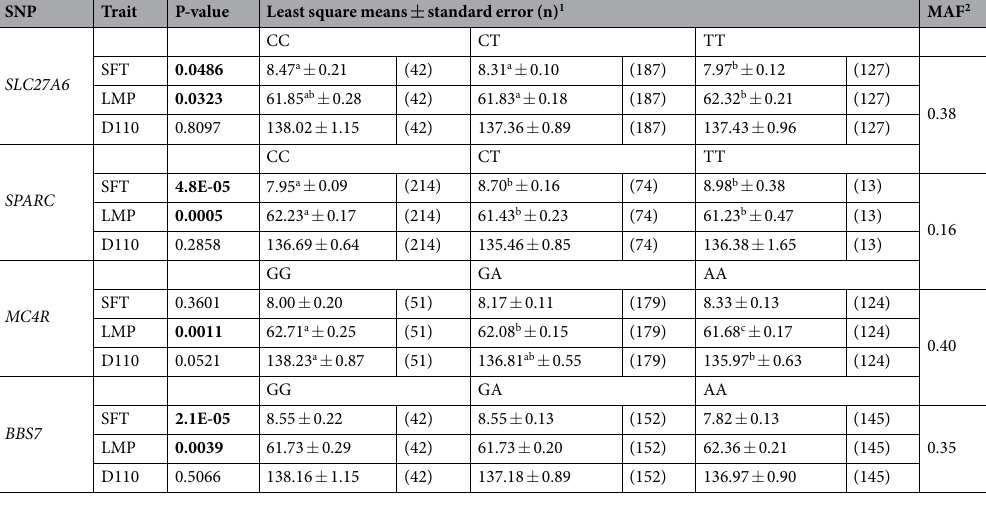
Table 2. Association of selected candidate gene polymorphisms with days to 110 kg (D110), lean mass percentage (LMP), and subcutaneous fat thickness (SFT). 1 Least square means for genotypes were compared by t -test and P -values were adjusted by Tukey-Kramer correction. Superscripts a,b,c indicate for significant differences at P < 0.05. Significant associations (P < 0.05) are highlighted in bold. 2 Minor allele